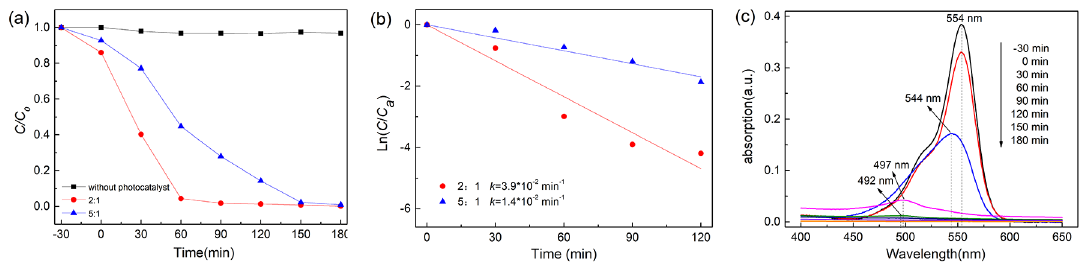
) and irradiation time for the RhB solution photodegraded a